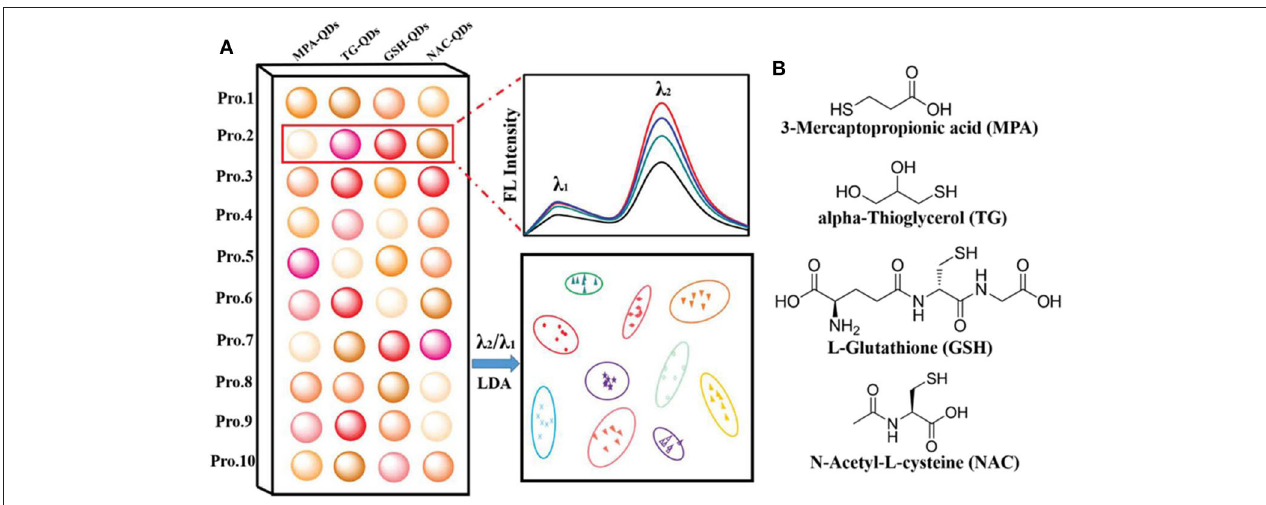
FIGURE 5 | (A) Photographs of the Au NCs in the absence and presence of human serums from five normal people (a–e), five hepatoma patients (f–j), and five thalassemia patients (k–o) under UV lamp. (B) LDA score plot for discriminating different human serums. Reprinted from Xu et al. (2014) with permission.